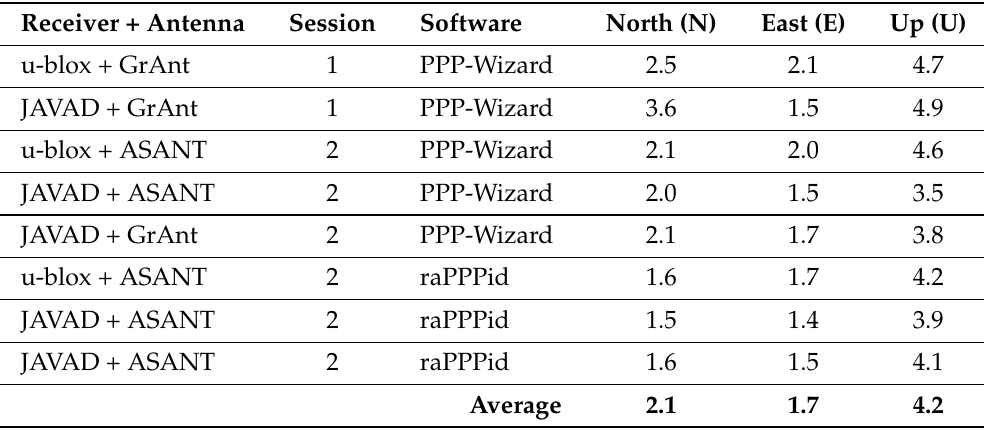
Table 3. RMS values for ambiguity float solutions of sessions 1 and 2 (in centimeters).